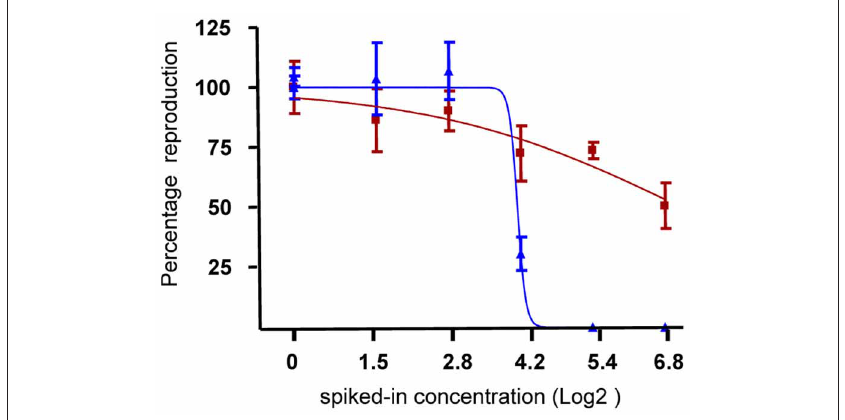
FIGURE 2 | Effect of soil and extract on reproduction of F. candida . Blue dots indicate the number of F. candida juveniles in the jars after 28 days exposure to 6 dilutions of soil samples. Red dots indicate the number of juveniles retrieved after 28 days exposure to dilutions of extract samples. The lines indicate the dose-response curves derived from a logistic model. X-axis, Log2 transformed spiked-in concentrations; y-axis, percentage reproduction scaled to the control samples (set at